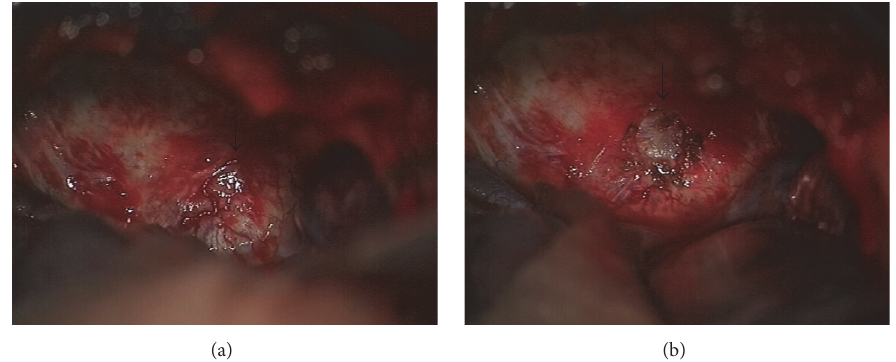
Figure 5: In (a), the arrow indicates the bulging of the lateral wall of the cavernous sinus caused by the tumour; in (b), the arrow points to the appearance of the tumour after the incision of the dura.